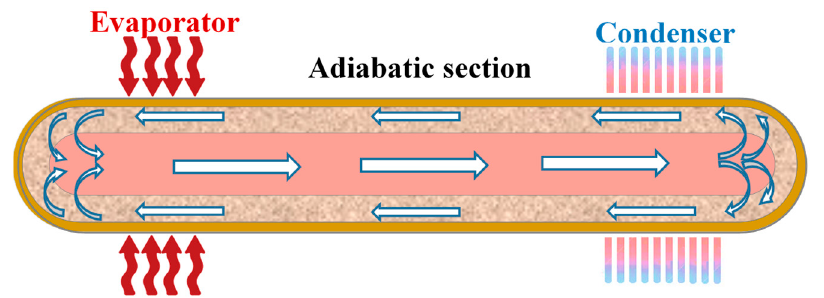
Figure 1. Circulation of the fluid inside the heat pipe.